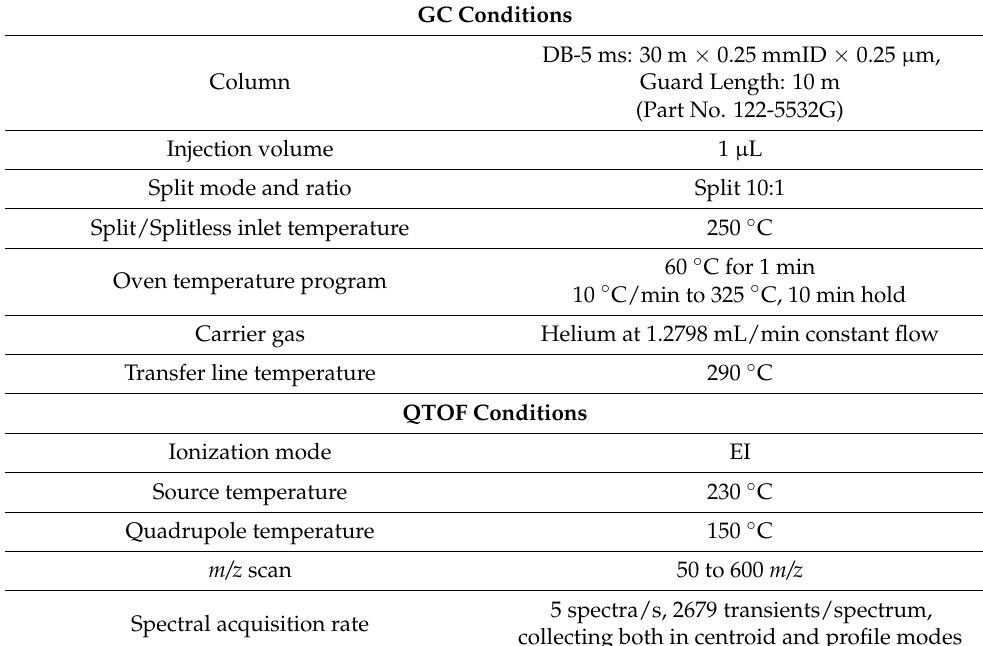
Table 3. Conditions used for